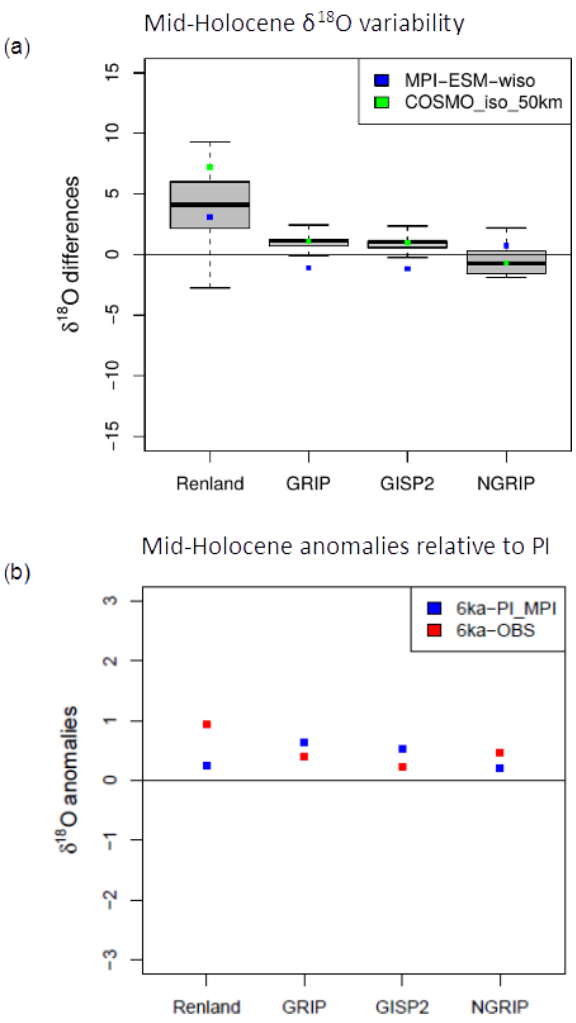
Figure 8. (a) Mid-Holocene isotopic ratio variability of the COSMO_iso_50km grid boxes surrounding four Greenland ice core samples. In each grid box, the observed ratios derived from the ice cores are subtracted from the simulated δ 18 O ratios. The black bar in the box and whisker plot represents the median of the isotope ra- tio difference distribution. The box comprises the upper and lower quartile, and the whiskers show the whole distribution. The MPI- ESM-wiso (blue dots) and COSMO_iso_50km (green dots) results for the grid points closest to the ice cores are also shown as differ- ences with respect to the observed δ 18 O ratios. (b) Anomalies of the MPI-ESM-wiso simulation relative to pre-industrial (PI) conditions, based on an MPI-ESM-wiso PI reference simulation (Cauquoin et al., 2019) are shown as blue points, and the observed anomalies for the mid-Holocene relative to present-day are shown as red points.